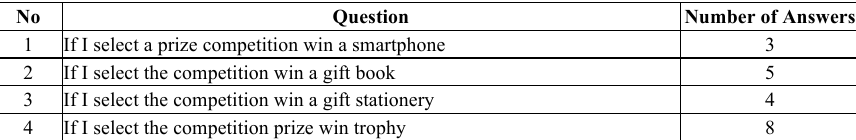
Table 1. The Questionnaire